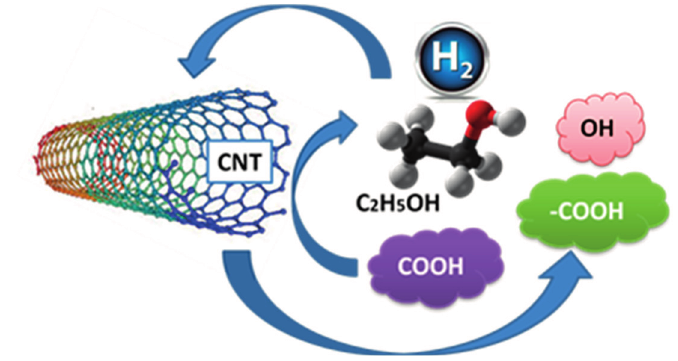
Figure 10. Schematic representation of ethanol sensing at CNT surface.